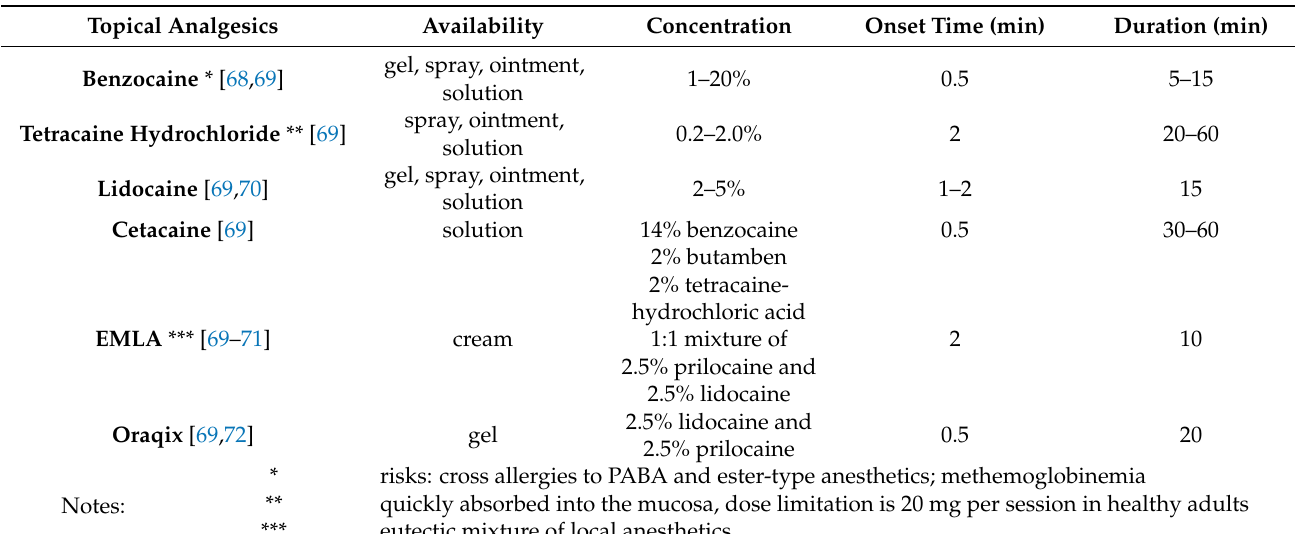
Table 5. List of topical analgesics, their availability, onset time, and